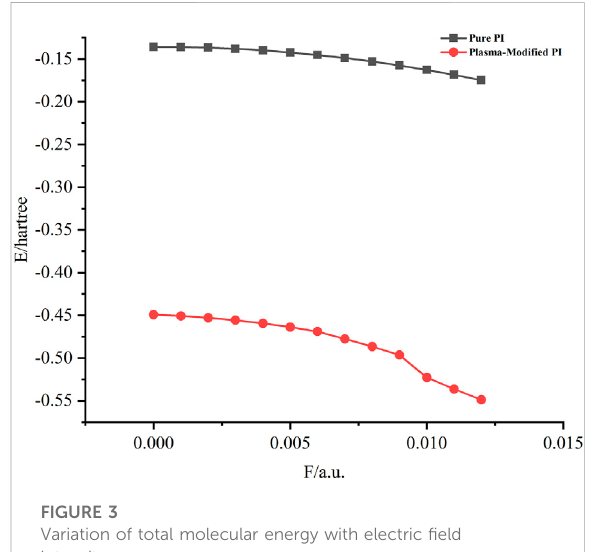
FIGURE 4 Variation of the molecular dipole moment with electric fi eld intensity.